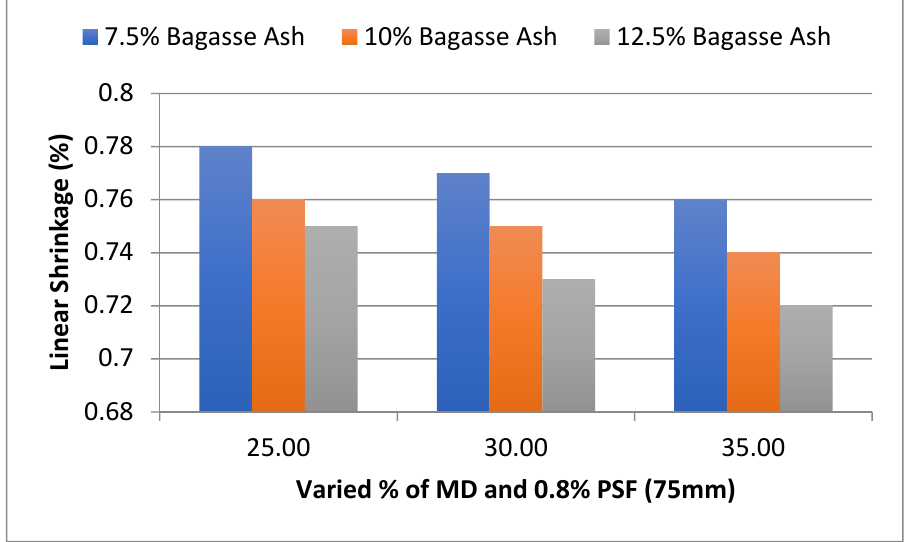
Figure 11. Effect of MD and BA on linear shrinkage of block reinforced with 0.8% PS fiber (75 mm).